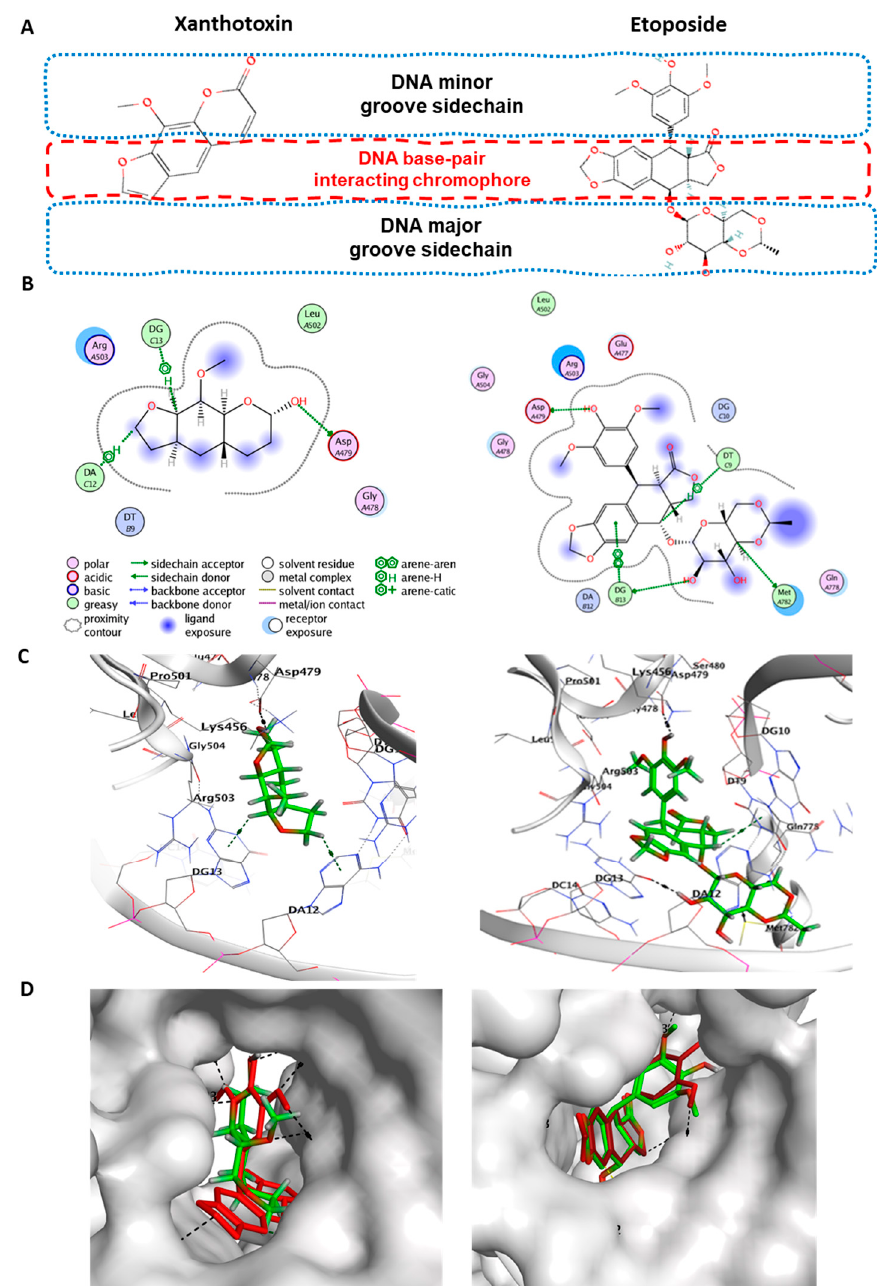
Figure 7. Binding modes of xanthotoxin and etoposide after docking in the active site of topoiso- merase II (PDB code: 3QX3). ( A ) The chemical structure of docked compounds xanthotoxin and etoposide. ( B ) Two-dimensional (2D) structures of ligand interactions. ( C ) 3D binding mode illus- trating their interactions both with the same amino acid Asp479 inside the human Topo II–DNA complex active site (rendered in stick mode and with hydrogen bonds represented in black dashed lines) and H–pi interactions with DNA nucleotides (in blue dashed lines). ( D ) 3D positioning and 3D molecular surface diagrams of xanthotoxin and docked etoposide (green sticks) along with the native co-crystalized ligand etoposide (red sticks) inside its active site.